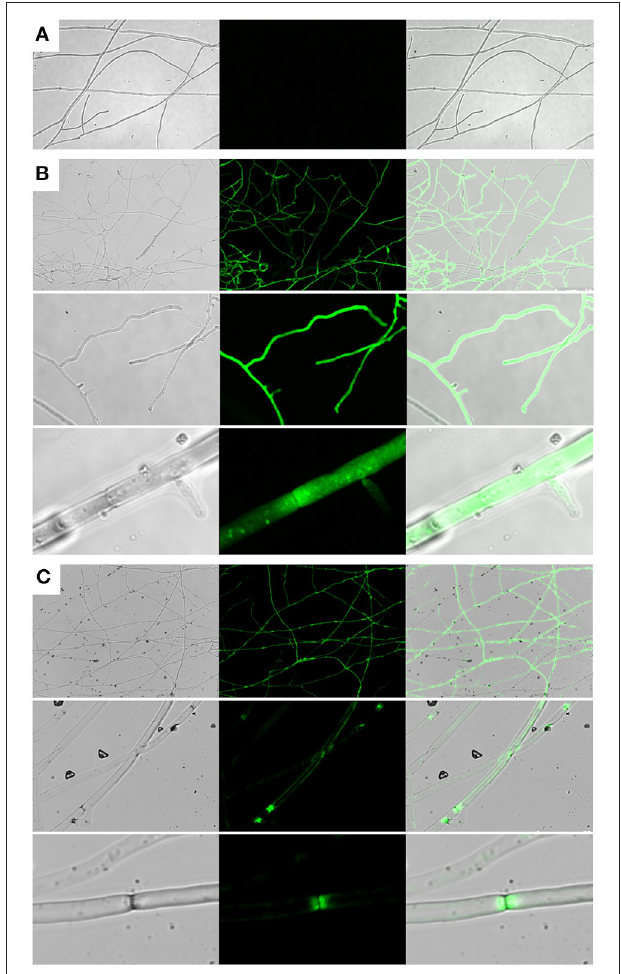
FIGURE 6 | Cprp localization in C. passeckerianus . (A) Wild-type C. passeckerianus . (B) C. passeckerianus expressing GFP from plasmid p004iGM3, showing dispersal throughout the hyphae. (C) C. passeckerianus expressing a Cprp-GFP fusion protein, showing clear septal localization and increased fluorescence at the cell wall. Each image shows a phase contrast image, a fluorescent image and a merged image (left to